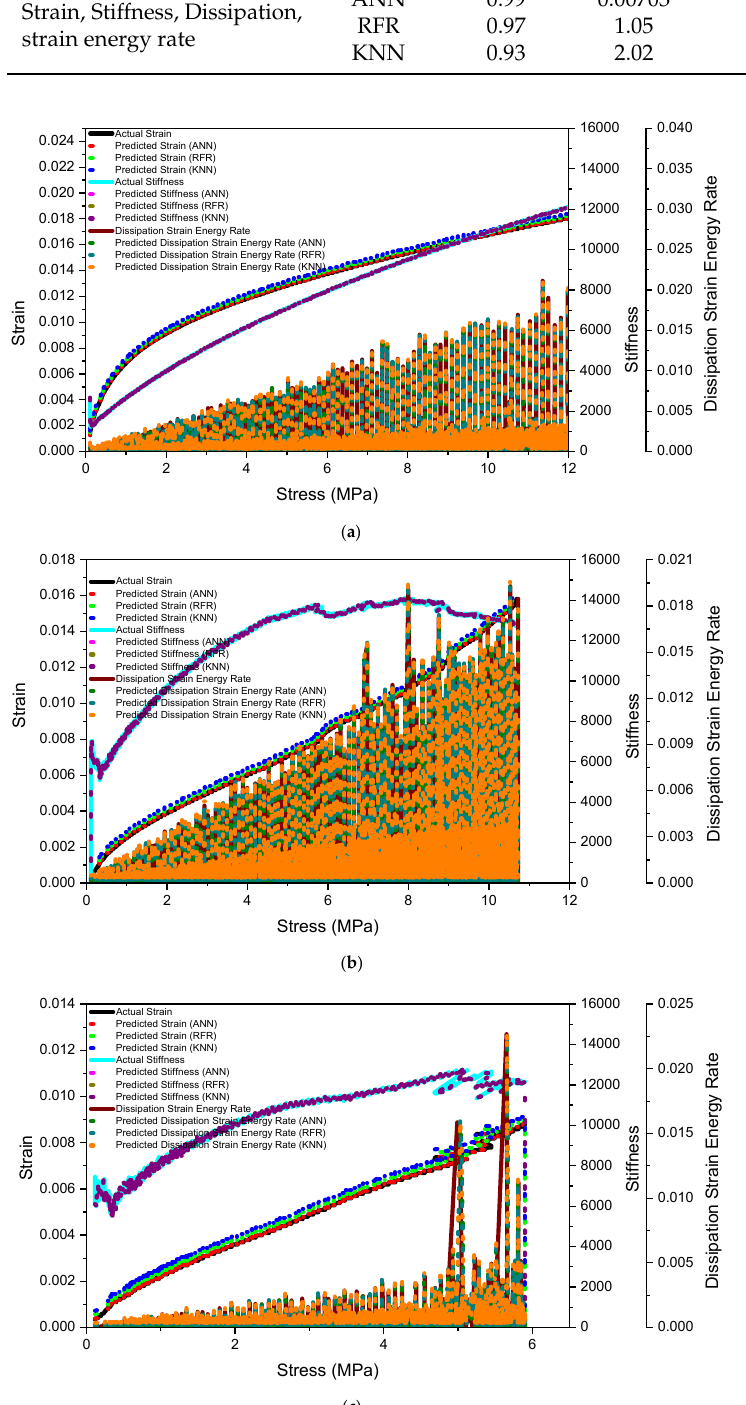
Figure 20. Evaluation of actual value and the predictive value using ANN of strain, stress, dissipated energy, and stiffness of ( a ) dry sample, ( b ) natural sample, ( c ) saturated sample.